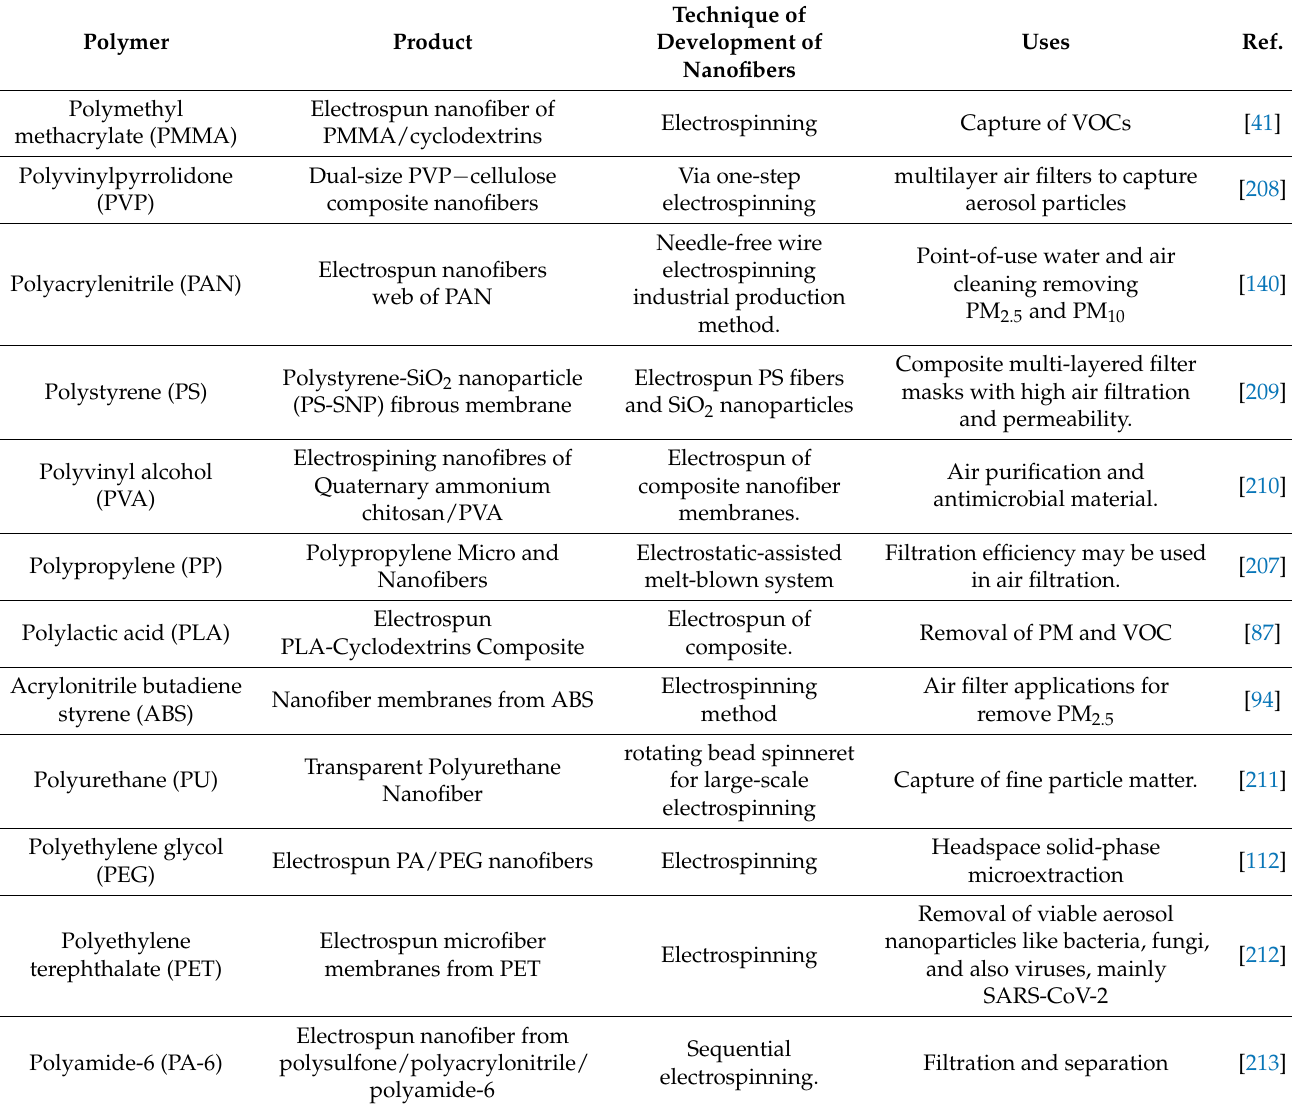
Table 3. A short list of nude and modified electrospun nanofibers, application to air